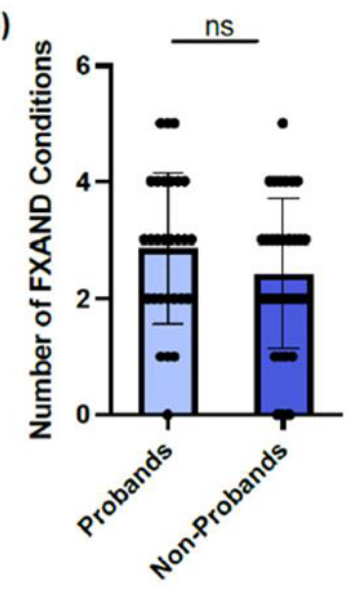
Figure 1. ( A ) Percentage of patients with 0, 1, 2, 3, 4 and 5 FXAND conditions. ( B ) Mean number of FXAND conditions in Probands and Non-Probands. Data mean ± SD. p = 0.1950.